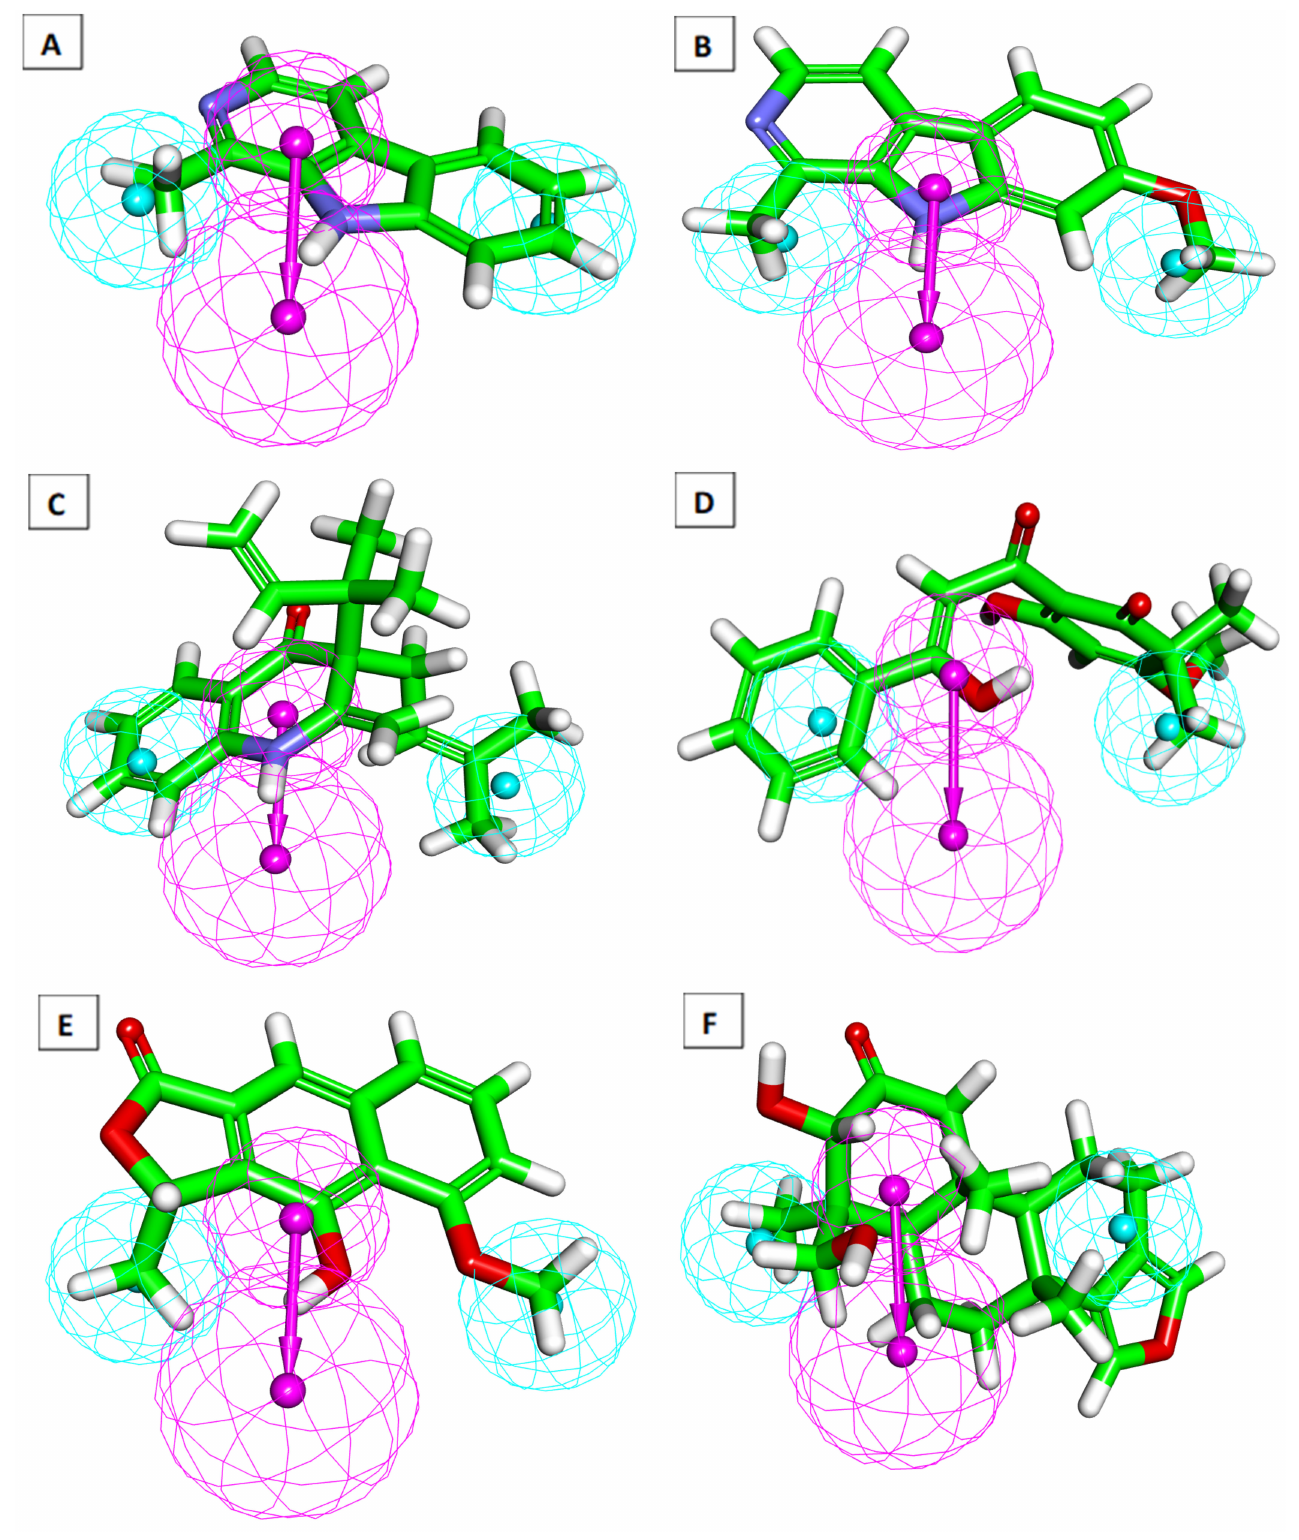
Figure 5. Mapping of the tested metabolites on the generated pharmacophore. ( A ) Metabolite 15 (fit value = 1.982), ( B ) metabolite 30 (fit value = 2.465), ( C ) metabolite 55 (fit value = 2.285), ( D ) metabolite 109 (fit value = 2.552), ( E ) metabolite 112 (fit value = 2.471), and ( F ) metabolite 234 (fit value =